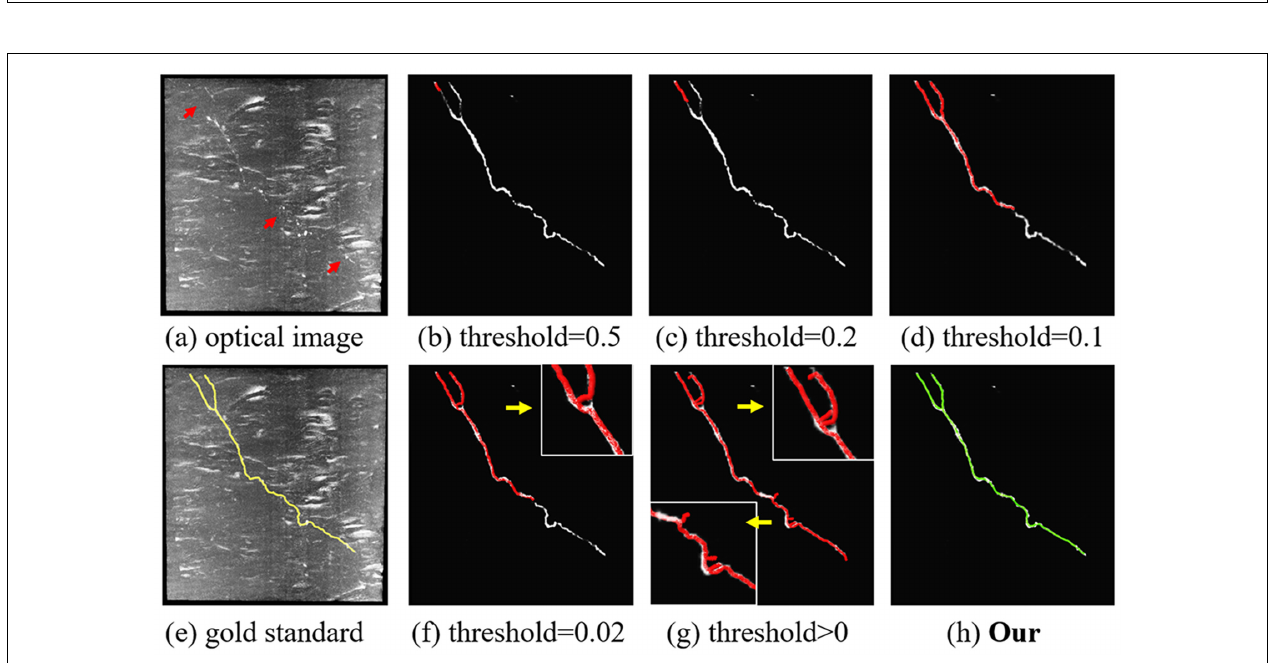
FIGURE 4 | Comparison of the proposed content-aware adaptive tracing (CAAT) (H) and typical threshold-based classification method (B–D,F,G) on neuron tracing with the same initial seed point. Optical image (A) ; gold standard (E) . Inaccurate traced areas were amplified in the white box.